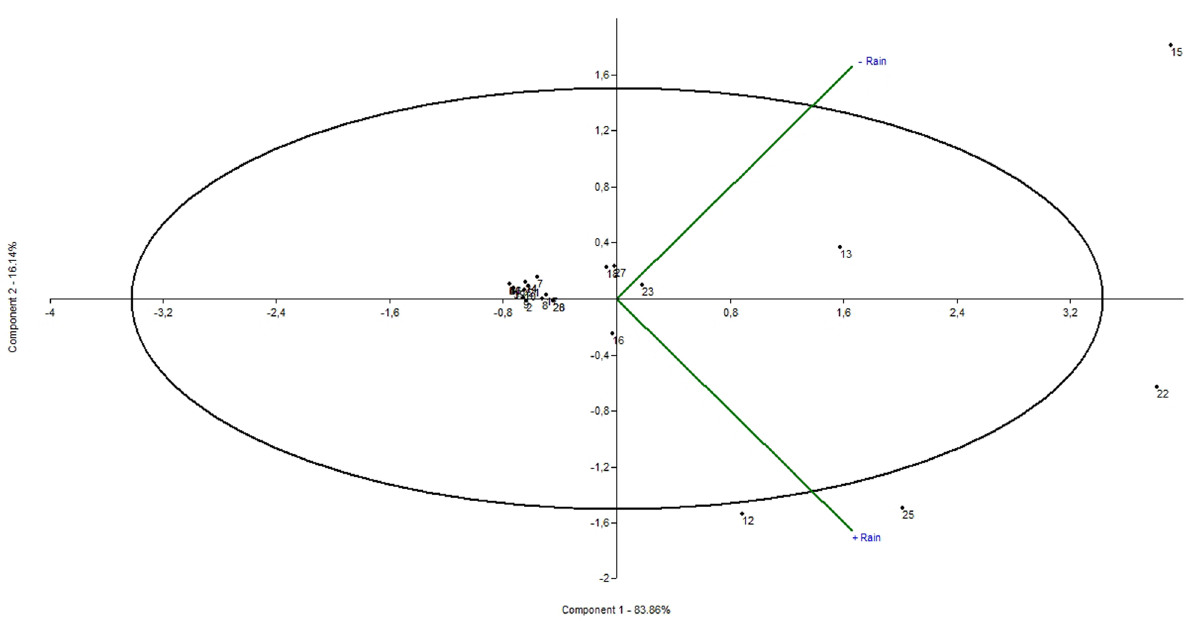
Fig 3 . Principal Components Analysis (PCA) between species and seasons. Ellipse indicates 95% confidence interval. Species farther from origin of axis are more representative of each season. Species names: 1. E. auripes; 2. E. concava; 3. E. flaviventris; 4. E. superba; 5. E. surinamensis; 6. E. vidua; 7. E. allosticta; 8. E. amazonica; 9. E. augaspis; 10. E. avicula; 11. E. bidentata; 12. E. cognata; 13. E. cordata; 14. E. gaianii; 15. E. ignita; 16. E. intersecta; 17. E. sp; 18. E. modestior; 19. E. mourei; 20. E. viridifrons; 21. E. bombiformis; 22. E. meriana;